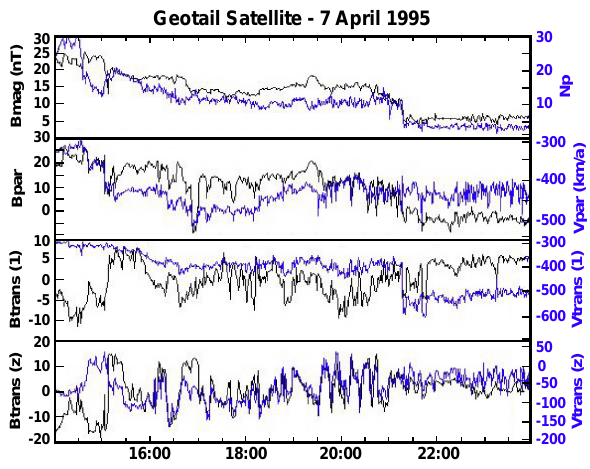
Fig. 8. Wind data in the solar wind inside the compression region, 19 June 1995. Top panel: magnetic field and density; bottom three panels: field-aligned and perpendicular components of b and v .